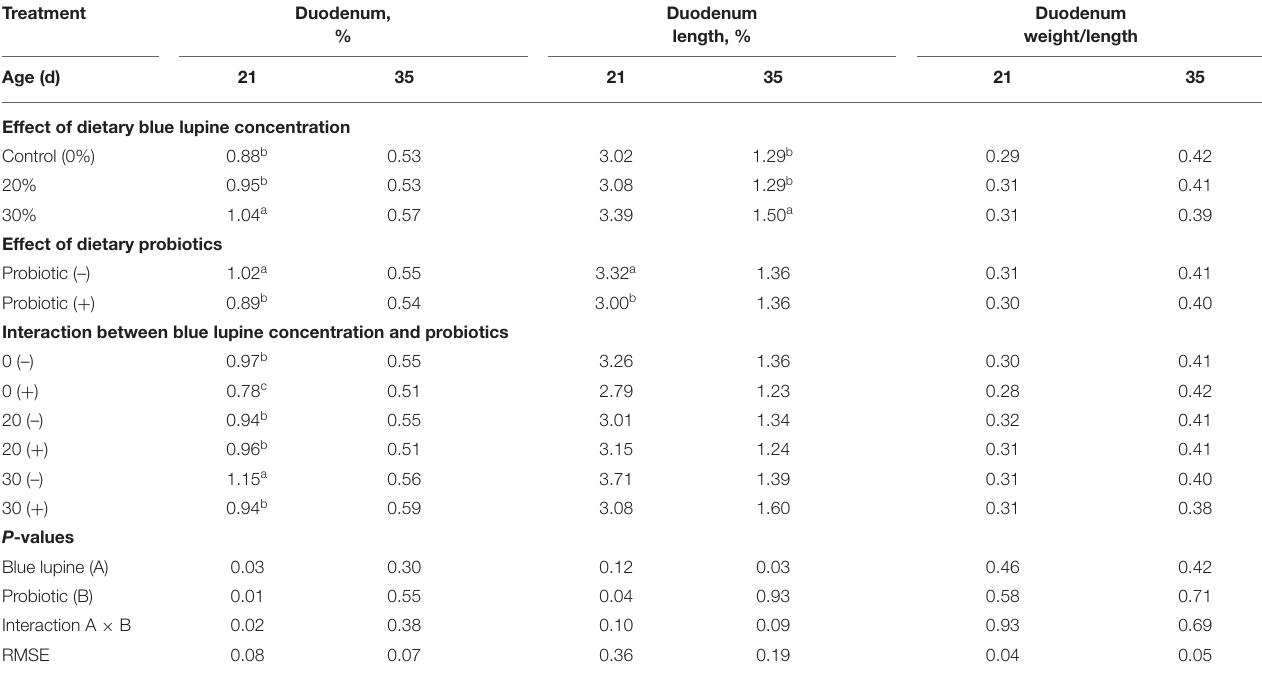
TABLE 8 | Effect of blue lupine, probiotics, and age of chickens on internal body organs of broiler chickens at 21 and 35 d of age. Treatment Duodenum,